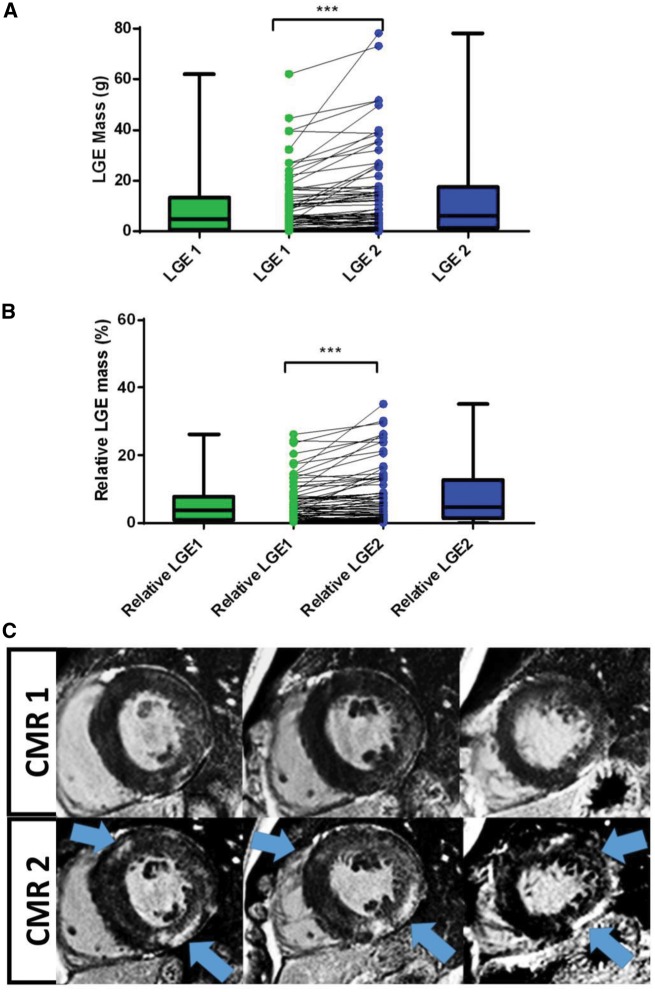
Comparison of (A) LGE mass and (B) relative LGE mass from CMR1 to CMR2 (***P < 0.0001, error bars represent SD). (C) a representative case of fibrosis progression in HCM (blue arrows indicate new regions of fibrosis).